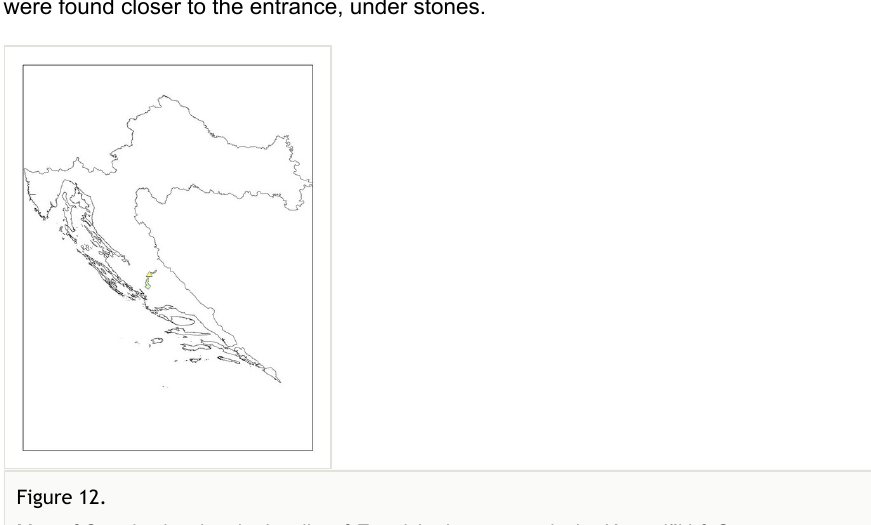
Map of Croatia showing the locality of Eupolybothrus cavernicolus Komerički & Stoev sp. n.